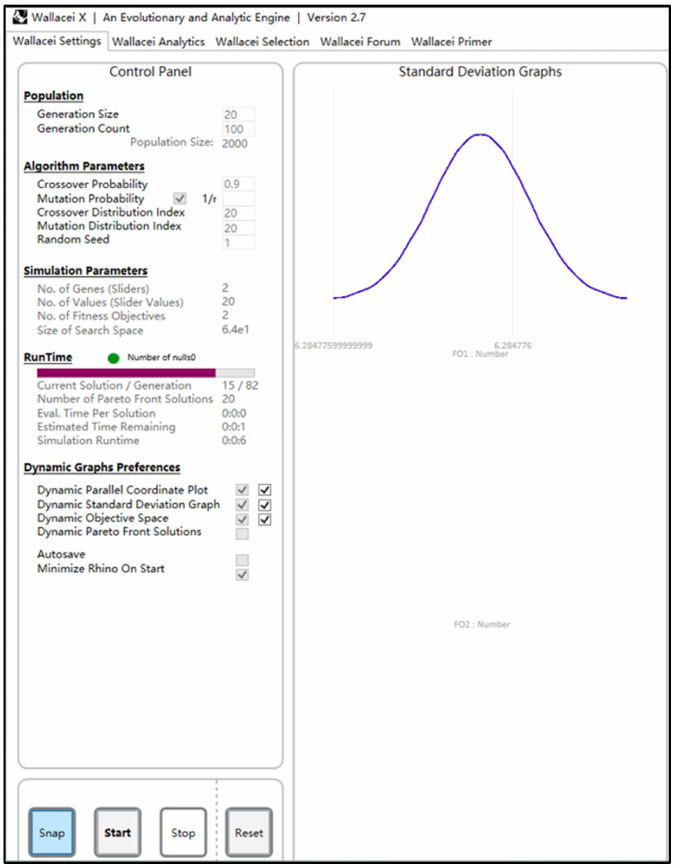
Figure 8. Wallacei component parameter setting